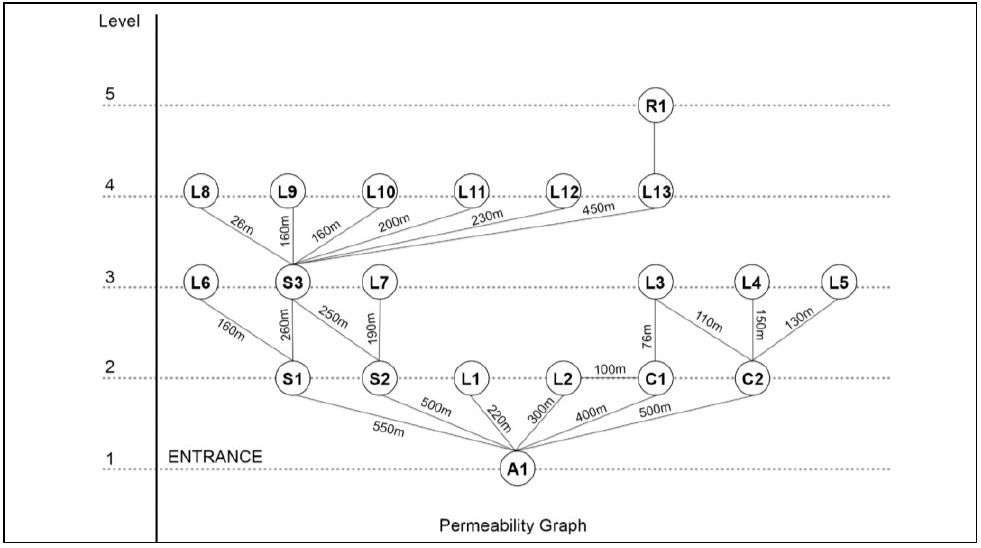
Figure 3. Justified Graph of Permeability